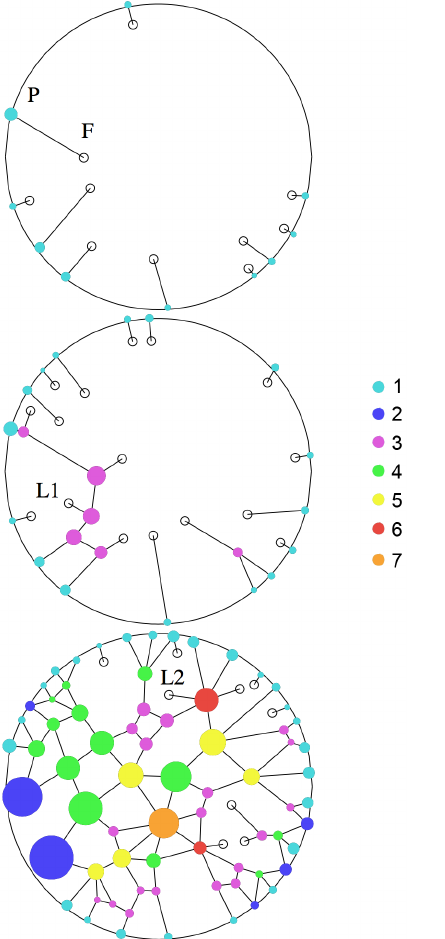
Figure 1. Typical evolution of a tunnelling network dug by A(0)=200 ants, at 5, 9 and 72 hours after T0. The outer circle represents the periphery of the sand disk (radius r ~ 100 mm). Plain disks represent chambers, and lines represent tunnels. Open disks denote active fronts (F), progressing from a peripheral node (P), from an existing gallery (L1) or from an existing node (L2).